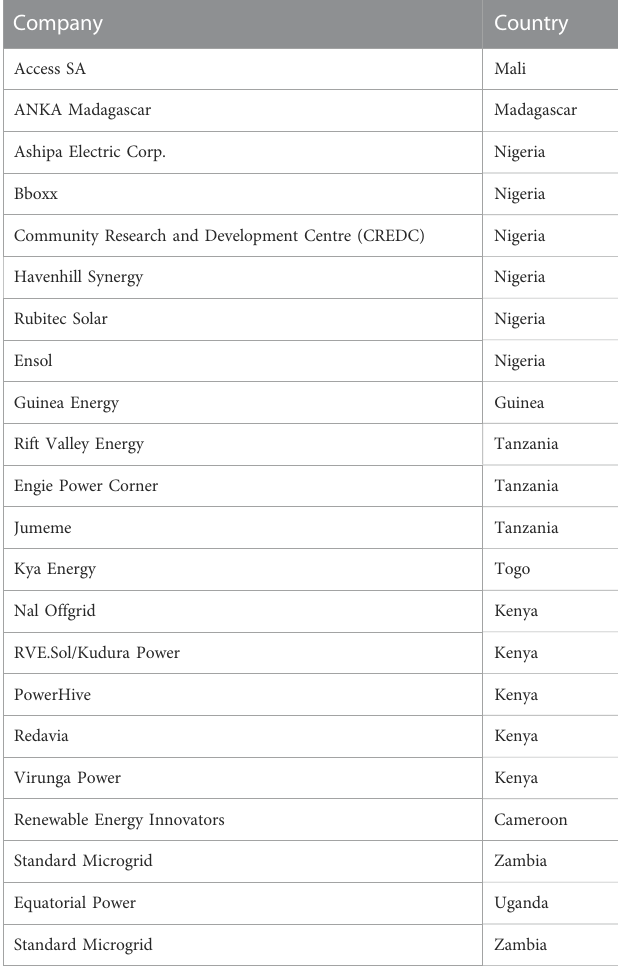
TABLE 11 For-pro fi t mini-grid developers in SSA. Company Access SA